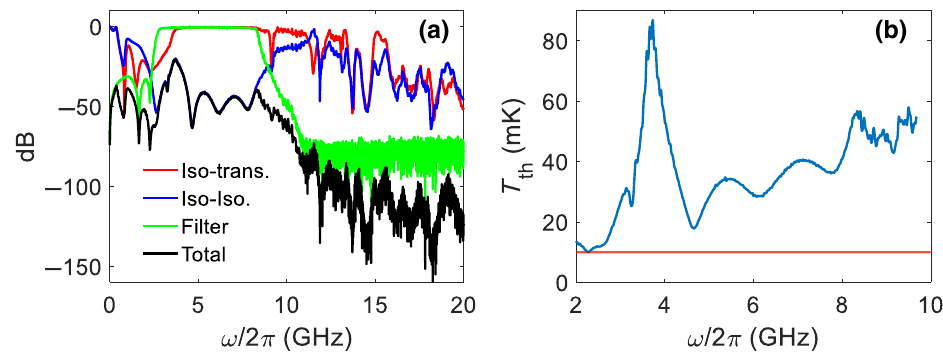
FIG. 6. Noise temperature. (a) The response of filters with a low-pass and high-pass filters and two single-junction isolators shown in Fig. 5, as a function of the input frequency ω . The data is measured by a VNA with dipping the microwave components into liquid nitrogen. Iso-trans. and Iso-Iso denote the transmission coefficient and the isolation coefficient of the two single-junction isolators, respectively. The green curve is the filters’ transmission coefficient. The black curve represents the total attenuation from the filters and the isolators. (b) The corresponding effective noise temperature T th reaching the sample from the HEMT amplifier after the isolators and filters (blue curve). The red curve is the noise temperature from the 50 (cid:5) terminators of the